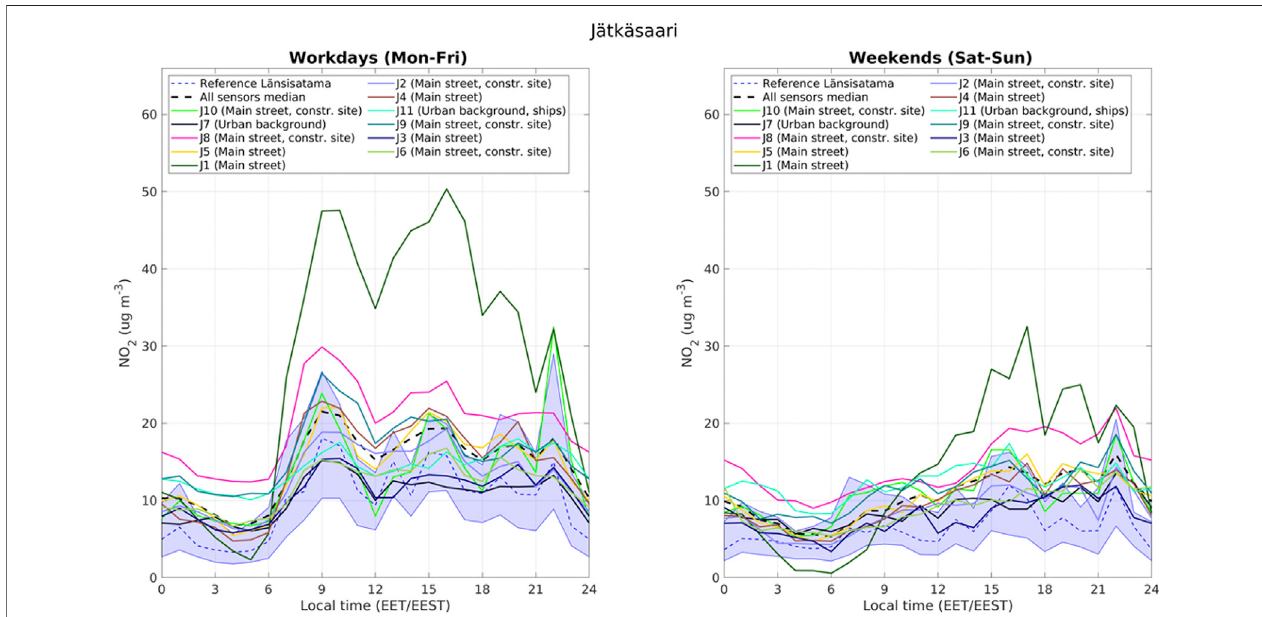
FIGURE9| Median diurnalcyclesofNO 2 during 5-month period (1.8.-31.12.2020)for sensors located in Jätkäsaari (left)workdays (Mon-Fri) and (right) weekends (Sat-Sun). Reference measurements show median (dashed line) and 25th and 75th percentiles (shaded area) from nearest reference instrument. Black dashed line shows median diurnal cycle calculated for all data from that